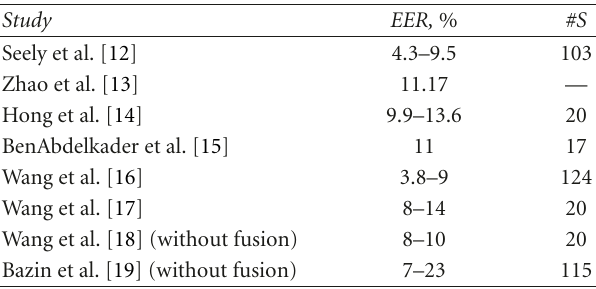
Table 1: Summary of some VS-based gait recognitions.